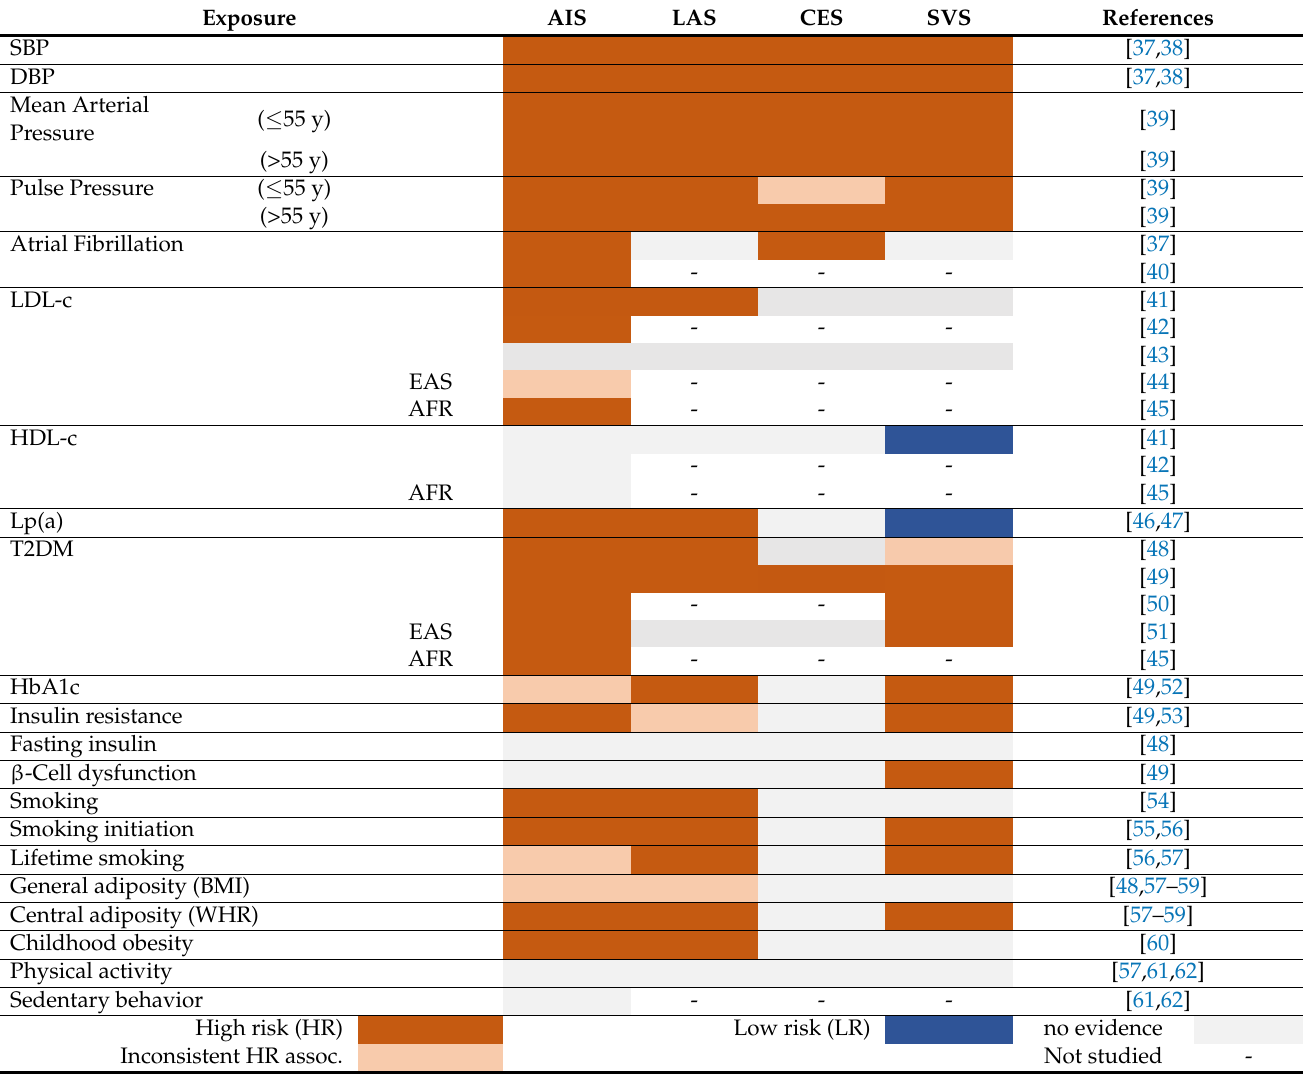
Table 1. Results from MR studies involving traditional stroke risk factors.